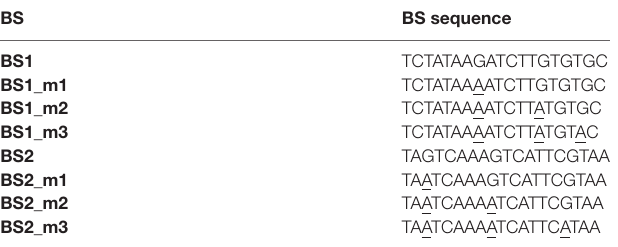
Table 2 | Mutated binding sites (BSs). bs